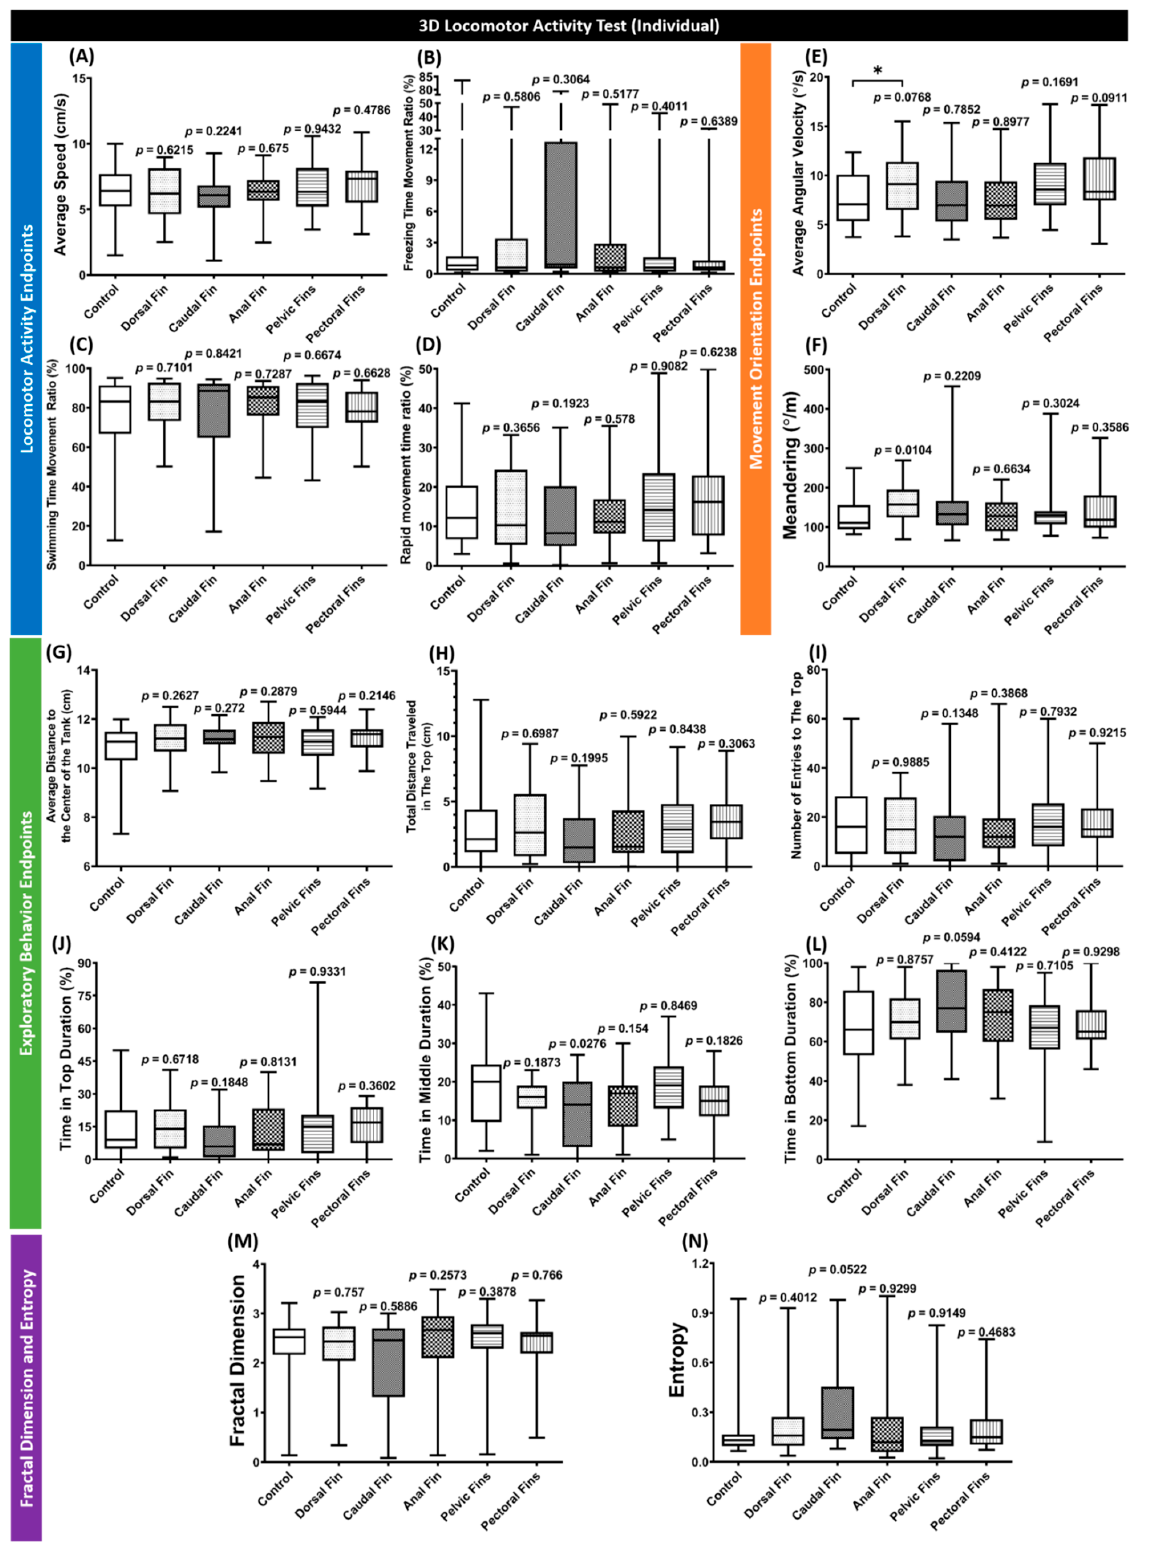
Figure A1. Comparison of individual zebrafish behaviors in 3D locomotion test among fin-amputated groups and a control group. Twelve endpoints were measured and categorized into three groups. ( A ) Average speed, ( B ) freezing time movement ratio, ( C ) swimming time movement ratio, and ( D )